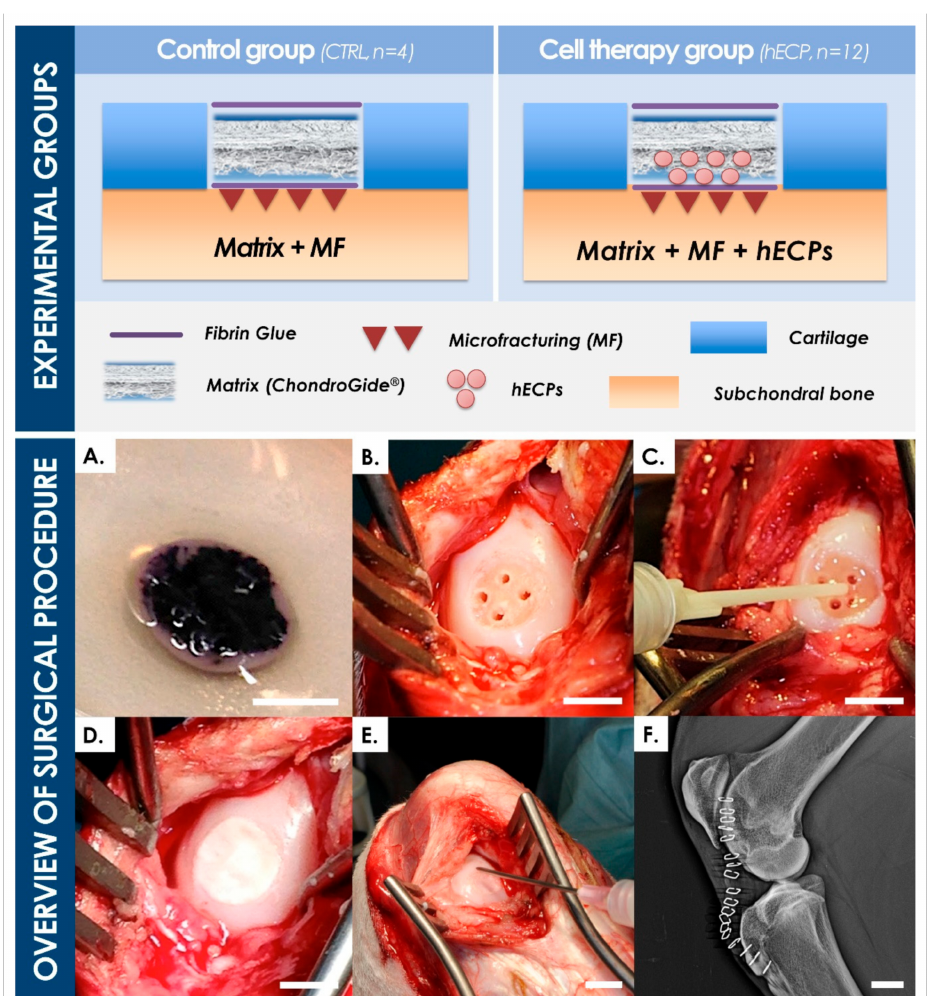
Figure 5. Caprine safety study design showing the artificial defects in the CTRL group receiving Chondro-Gide ® matrix, loaded with normal sterile saline, and glued over the microfracture drill holes with fibrin sealant. The hECP group received the same matrix, seeded with 1.2 million freshly thawed hECP cells suspended in saline, glued over microfracture drill holes with fibrin sealant. In both cases, fibrin sealant was also applied on top of the membranes, to improve fixation. ( A ) Seeded constructs displayed strong purple staining of seeded cell (i.e., indicating metabolic activity in the MTT assay) after two hours of incubation at room temperature, in the same conditions as those followed prior to implantation. ( B ) The surgical procedure comprised creation of four microfracture drill holes within the created defect, through the subchondral bone plate. ( C ) Fibrin glue was then added to the bottom of the defect filling and covering the created microfracture drill holes. ( D ) The bioengineered construct was then implanted in the defect, with the rough side facing downward and the smooth side facing toward the surface. ( E ) Fibrin glue was additionally deposited on top of the construct membrane to reduce the subsequent risk of delamination. ( F ) Suturing of the capsule was performed, and soft tissue was replaced back together, before control X-rays were performed to evaluate the surgical procedure and to establish a baseline (i.e., monitor the potential subchondral bone cyst formation). Imaging represents the operative and post-operative procedures for medial condyles of ECP1 (i.e., B , D ), ECP2 (i.e., C ), and ECP4 (i.e., E , F ). Scale bars = 5 mm ( A ); 6 mm ( B – E ); 12 mm ( F